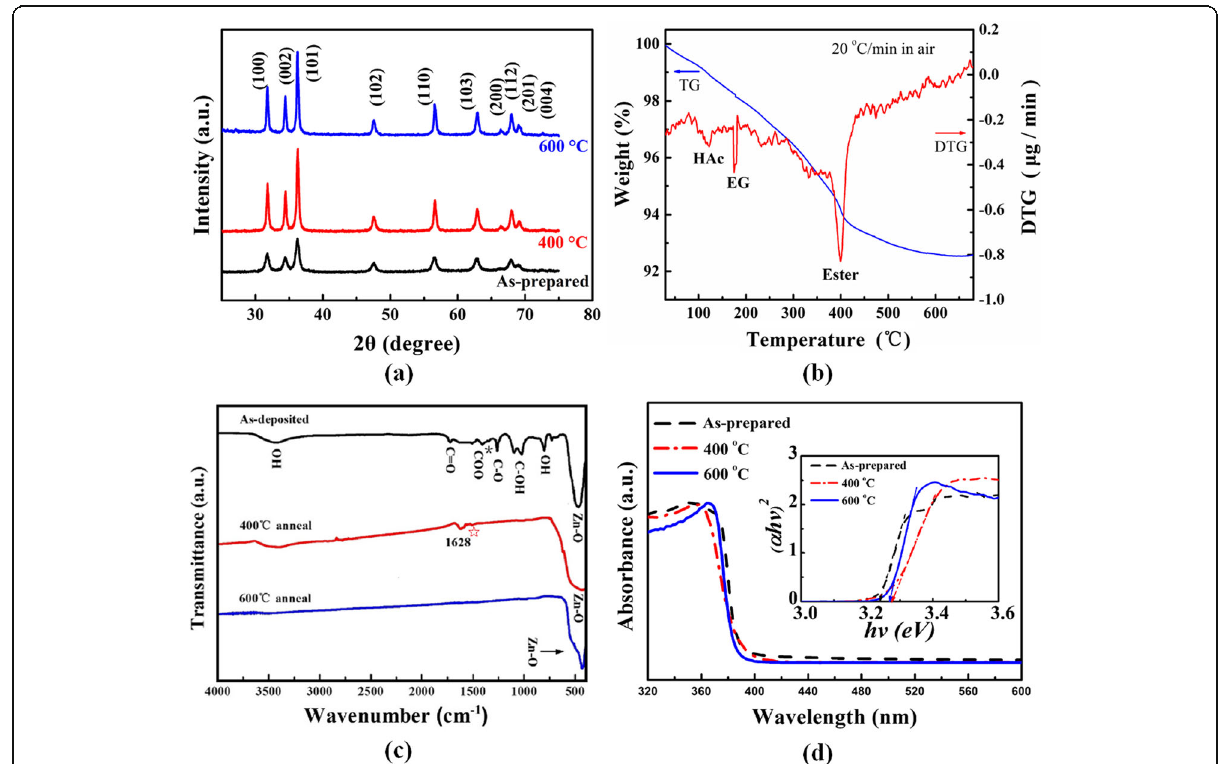
Fig. 2 ( a ) XRD patterns of as-prepared, 400 and 600 °C annealed ZnO nano-clip samples. ( b ) TG-DTG curves of as-prepared ZnO nano-clips heated in air. ( c ) FTIR spectra of as-prepared, 400 and 600 °C annealed ZnO nano-clip samples. ( d ) UV – visible absorbance spectrum of as-prepared, 400 and 600 °C annealed ZnO nano-clip samples. The inset in ( d ) is a corresponding curve of ( α hv ) 2 dependence on